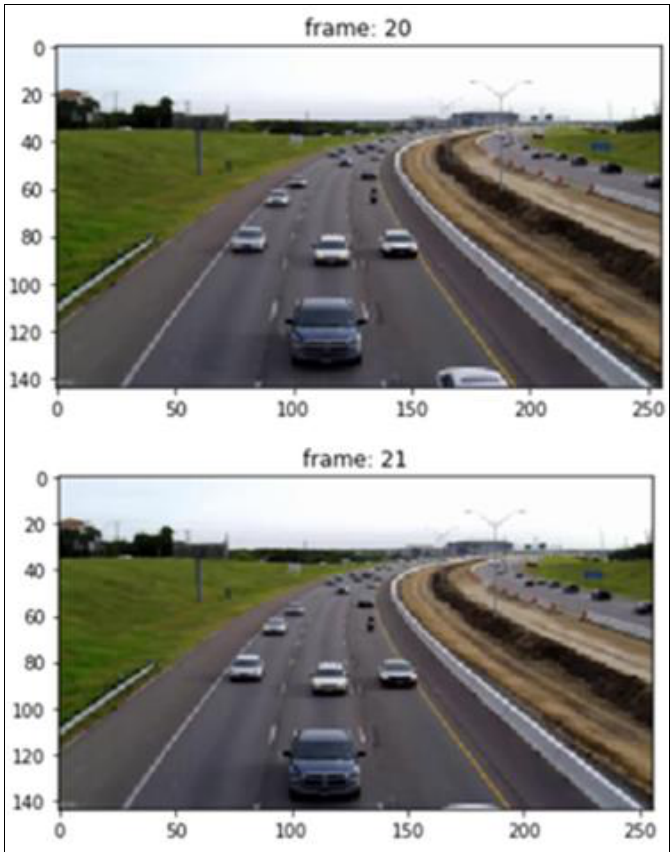
Figure 3: Continuous frames from input